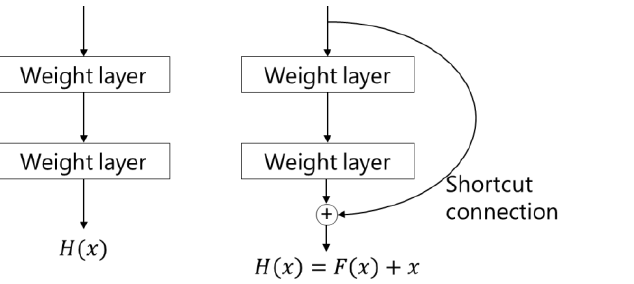
Figure 3. Residual block and shortcut connection ( left : general network, right : residual block).